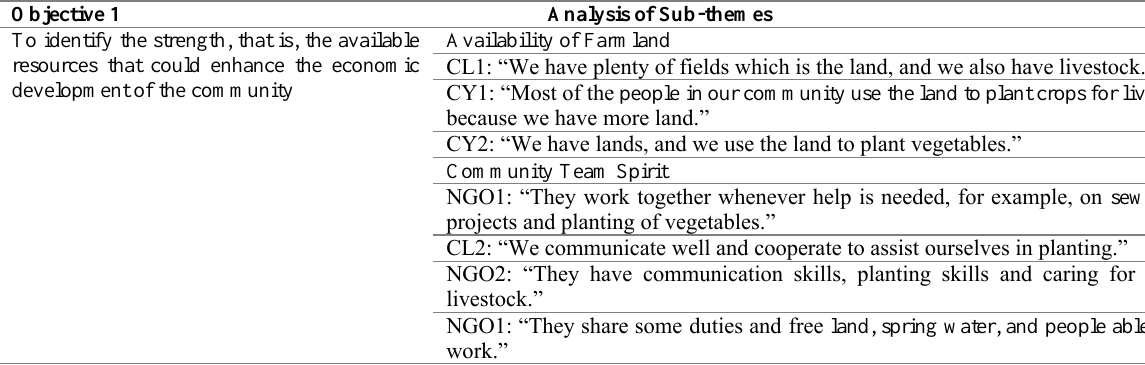
Table 1: Thematic representation of data based on the research objective